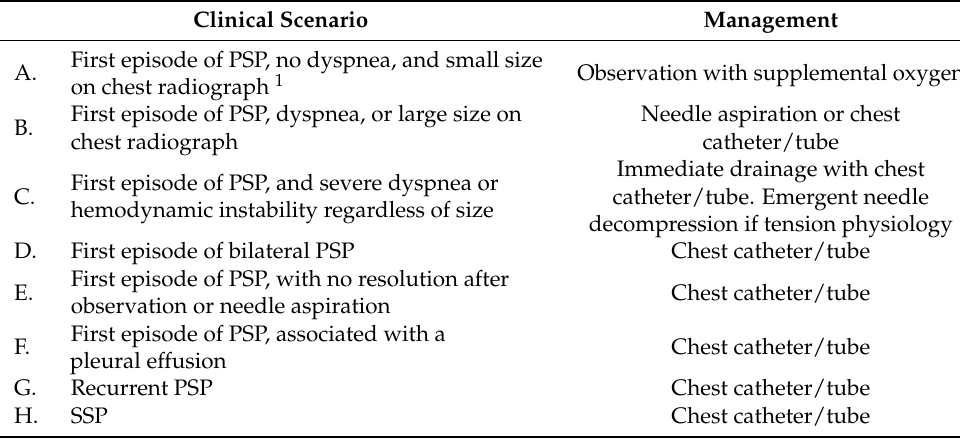
Table 1. Initial treatment of spontaneous pneumothorax.